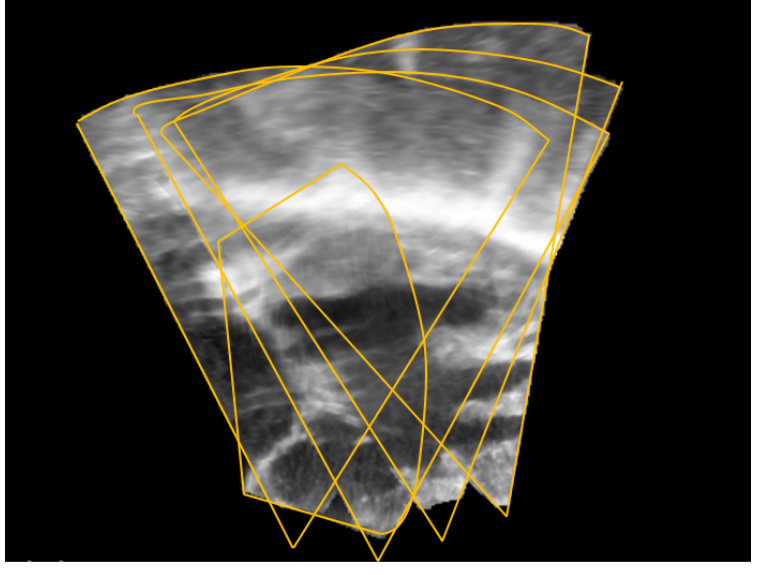
Figure 1. Compounded TEE volume of mitral valve with individual acquisitions outlined.